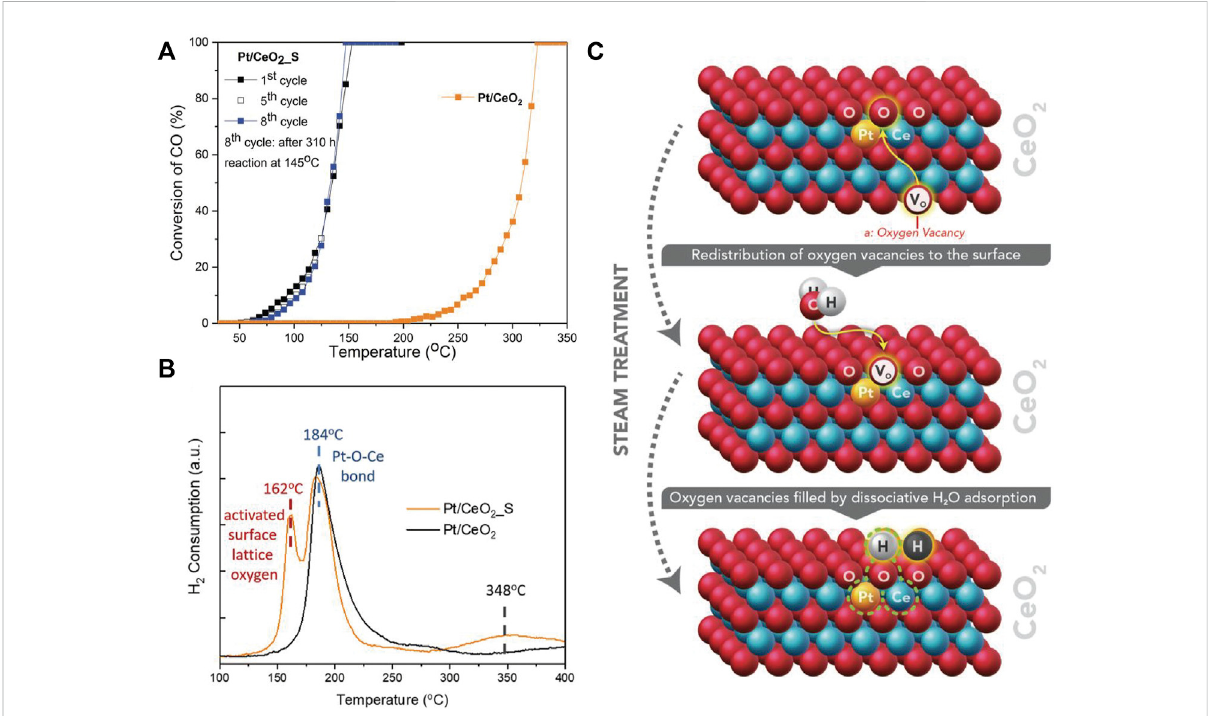
FIGURE 5 (A) CO oxidation performance and (B) H 2 -TPR pro fi les of Pt/CeO 2 and Pt/CeO 2 with steam treatment (Pt/CeO 2 _S); (C) Illustration of active